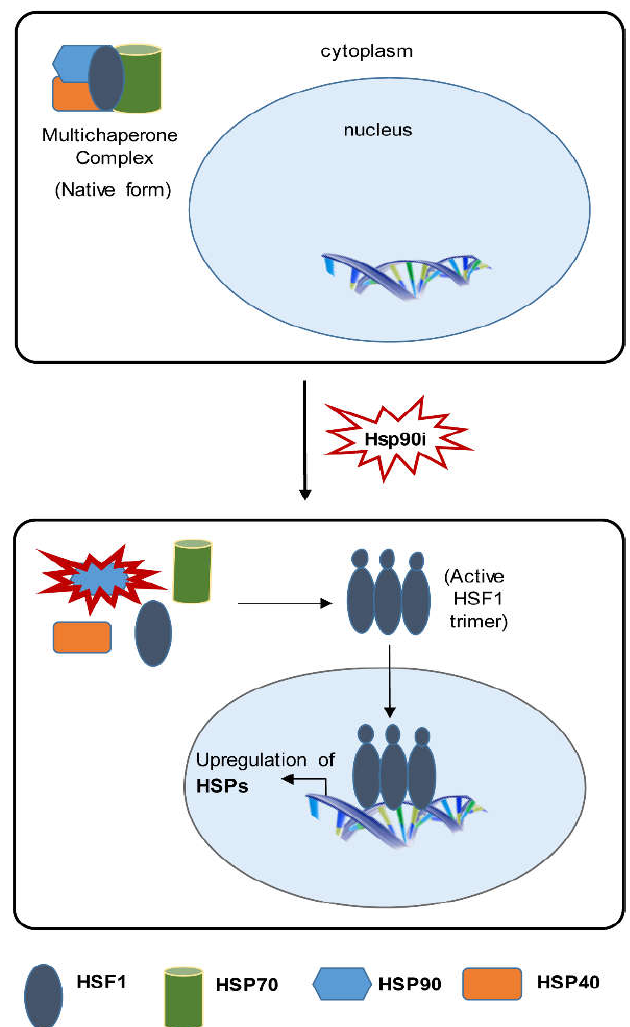
Figure 1. HSP90 inhibitors disrupt the multichaperone complex of HSF1 with other HSPs, subsequently leading to phosphorylation, nuclear translocation, and binding to heat shock elements in DNA, resulting in upregulation of HSPs for cancer cell survival.